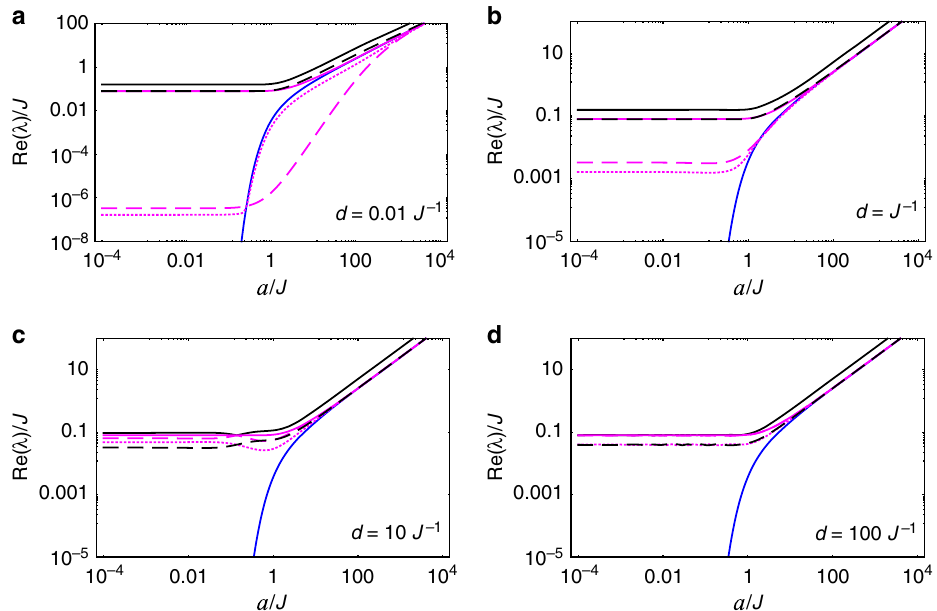
Fig. 4 Acceleration dependence of relaxation/decoherence rates of the spin system with different proper accelerations. We plot the decay rates (normalized by q 2 and measured by observers at spin-A location), Re( λ k ), of the decaying modes of the spin system, as functions of the spin-A acceleration a , for different separations d . We use the same style code as in Fig. 2, to which it is almost identical